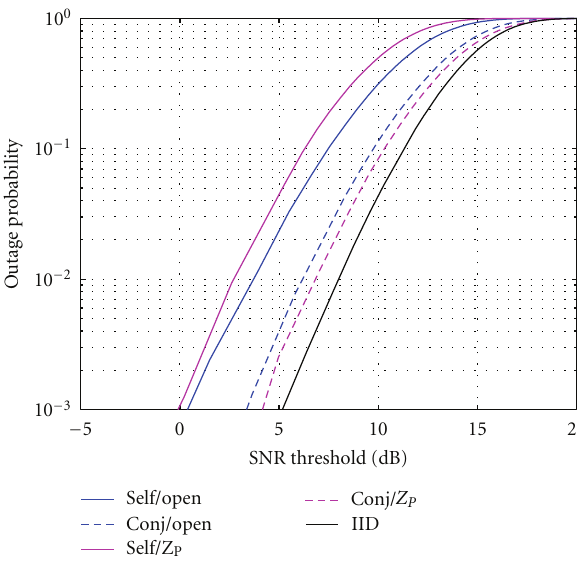
Figure 6: Traditional antenna selection (ULA): (5,2). Figure 7: Parasitic antenna selection (UCA):